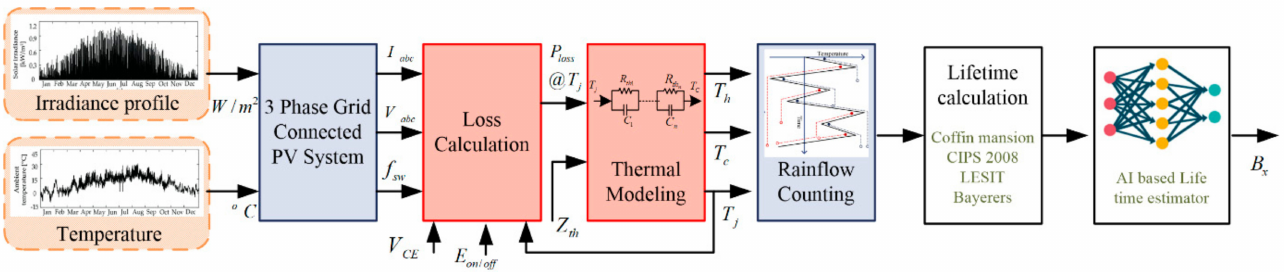
Figure 12. Schematic for implementing AI techniques for fault detection in grid-connected PV systems.